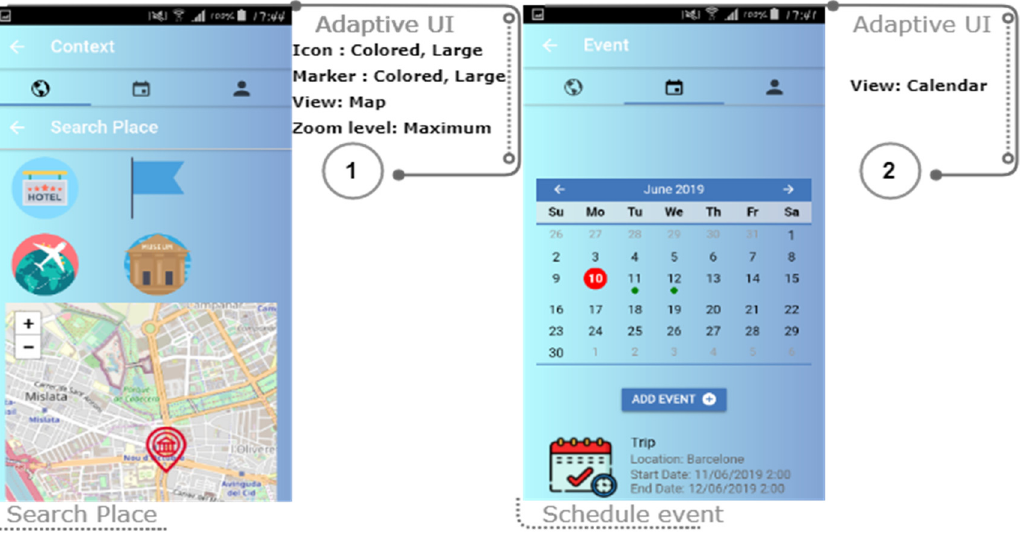
Figure 10. Scenario case adapted to users with low vision